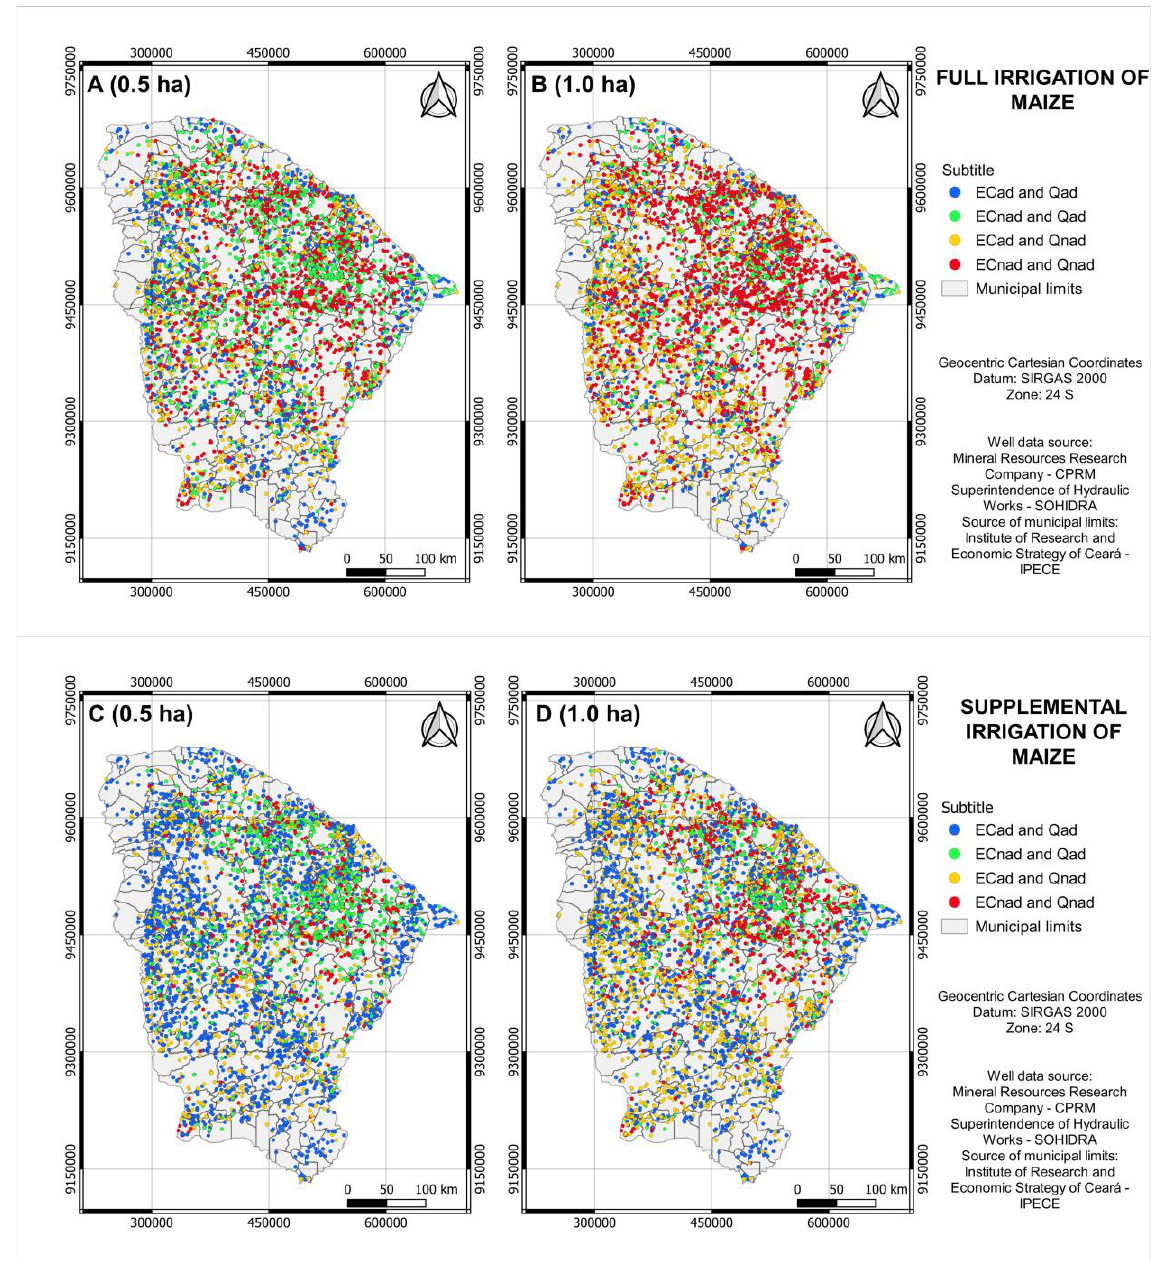
Figure 3. Potential of brackish groundwater in the State of Ceará (Northeast Brazil) for full irrigation of maize in 0.5 ha ( A ) and 1.0 ha ( B ), and supplemental irrigation of maize in 0.5 ha ( C ) and 1.0 ha ( D ), based on the threshold electrical conductivity of the irrigation water (EC) and discharge rate (Q). EC ad : adequate electrical conductivity; EC nad : inadequate electrical conductivity; Q ad : adequate discharge; Q nad : inadequate discharge.